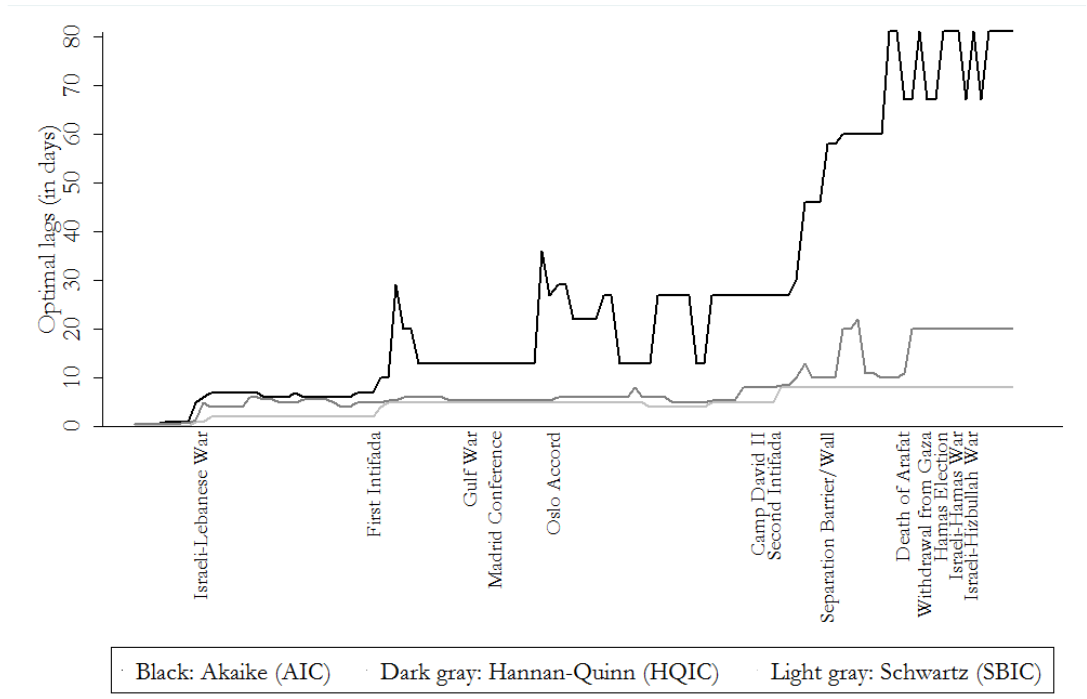
Figure 4: Duration Shock: Changes in Optimal Lag Structure, 1979-2009. Legend: Optimal lag structures fluctuate as the window of observations is extended over time.